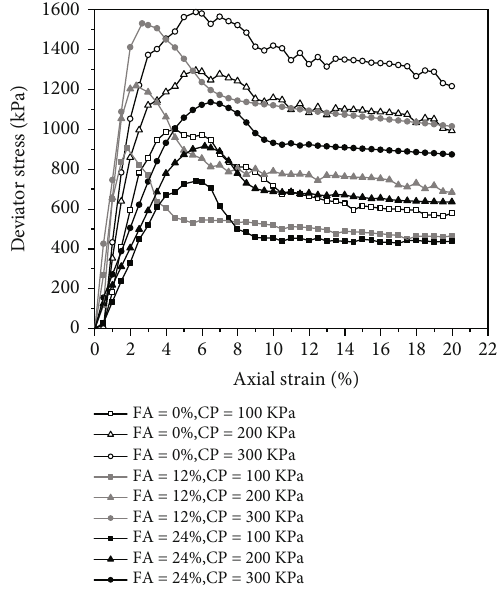
Figure 9: Stress-strain curves ( FT = 0 , L = 12 % ).